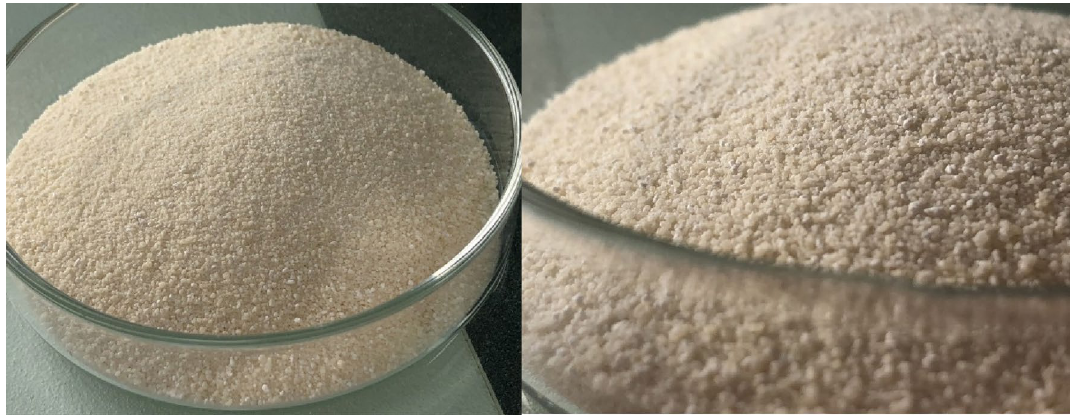
Figure 2. Images of produced PCT-EuE granules.